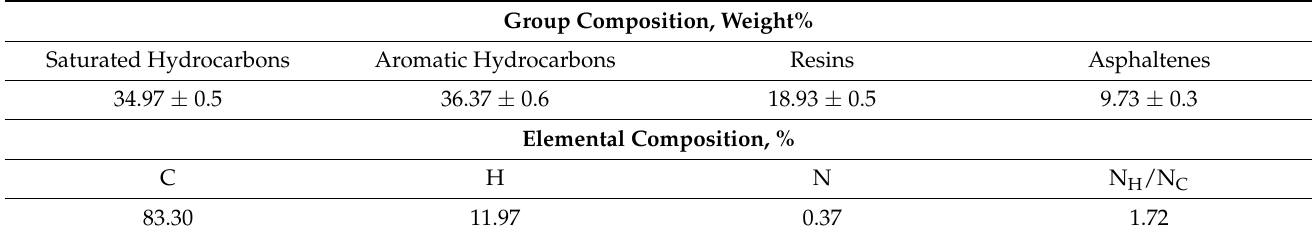
Table 1. Heavy oil physical properties and SARA analysis. Group Composition, Weight%.